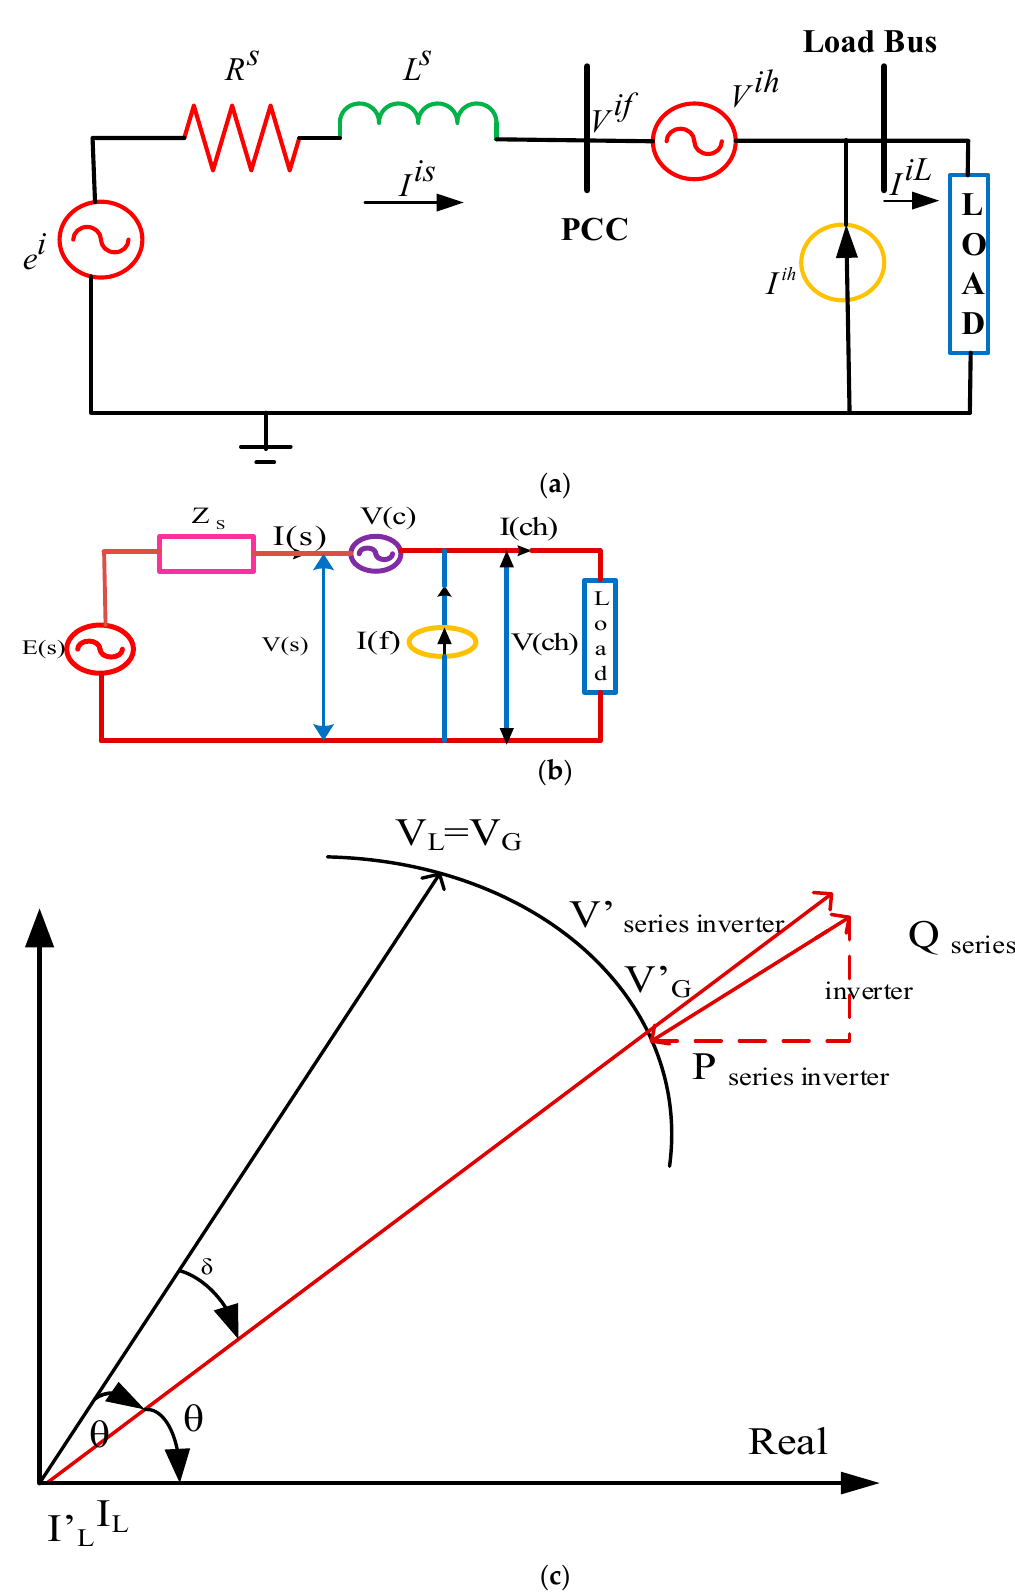
Figure 4. Analysis of ( a ) Equivalent circuit ( b ) Equivalent circuit model of UPQC and ( c ) Vector diagram of voltage compensation.